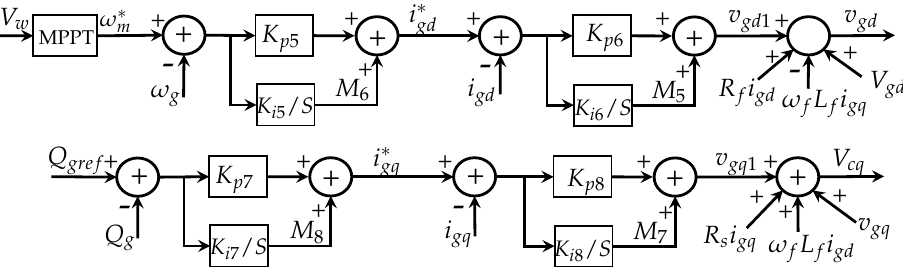
Figure 3. GSC control scheme with MPPT control and reactive power injection for LVRT